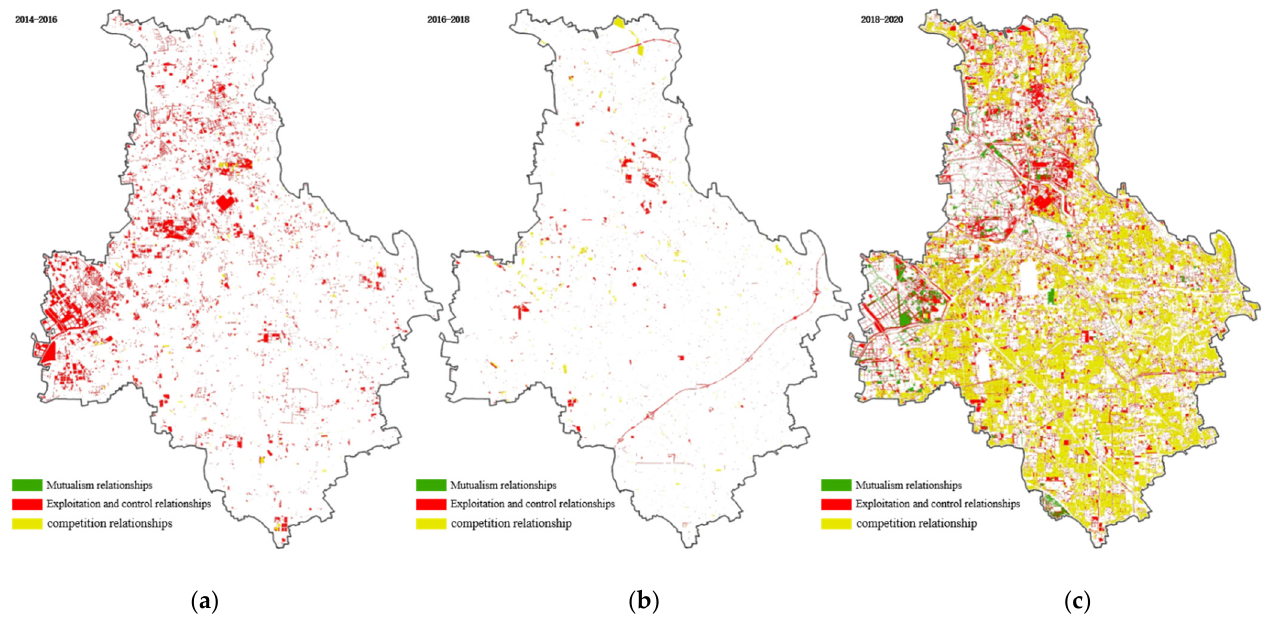
Figure 6. Spatial distribution of ecological relationships: ( a ) spatial distribution of ecological rela- tionships from 2014 to 2016; ( b ) spatial distribution of ecological relationships from 2016 to 2018; ( c ) spatial distribution of ecological relationships from 2018 to 2020.